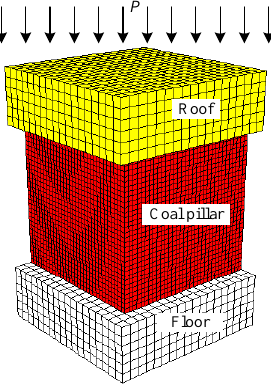
Figure 7. A stress mesh model of a floor-pillar-roof system.